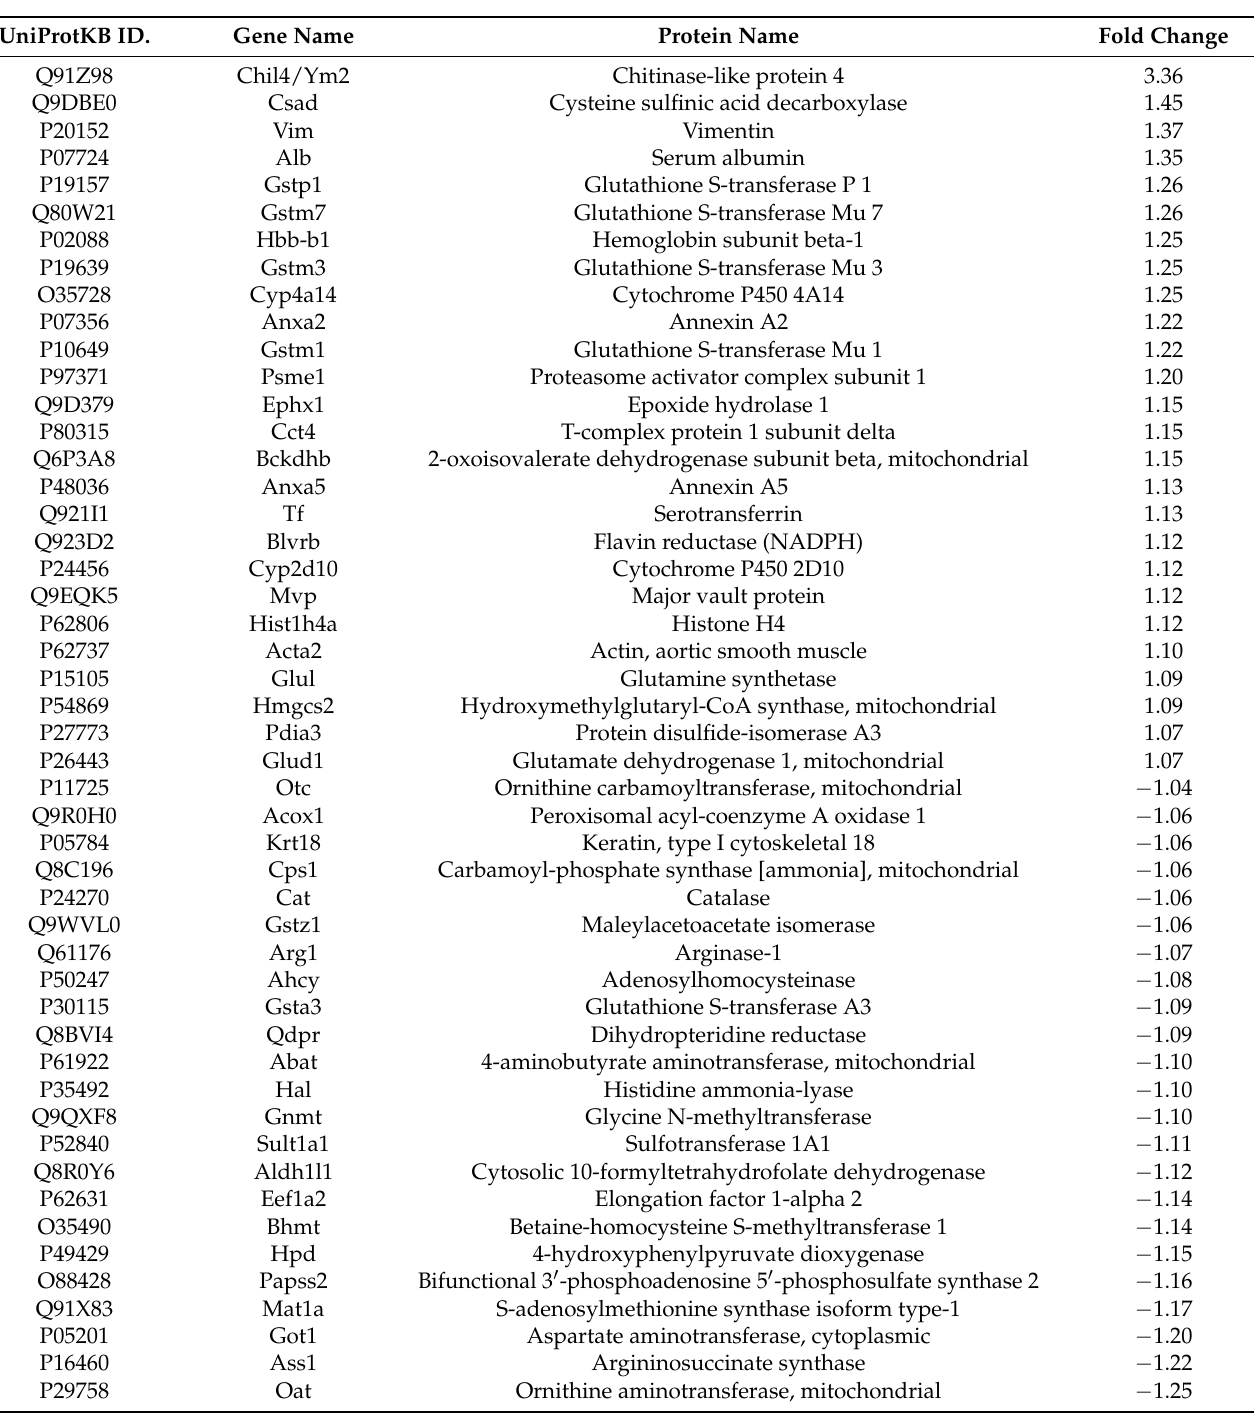
Table 1. Differentially expressed proteins in the liver of apoE − / − mice treated with DIZE as compared to the control group ( p < 0.05, n = 4 per group). UniProtKB